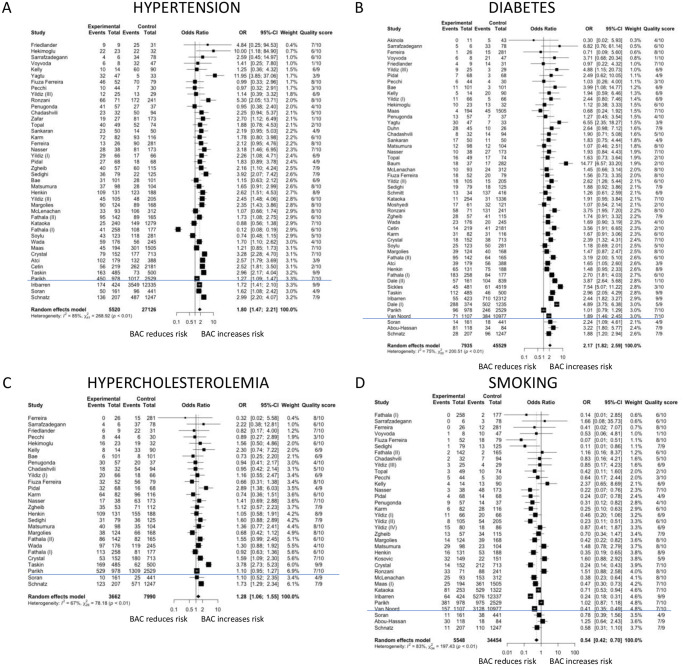
Forest plots of associations of breast arterial calcification with cardiovascular risk factors.Odds ratios are shown for studies reporting data on hypertension (Fig 4A), diabetes mellitus (Fig 4B), hypercholesterolemia (Fig 4C) and smoking (Fig 4D). The blue line separates cross sectional and cohort studies.